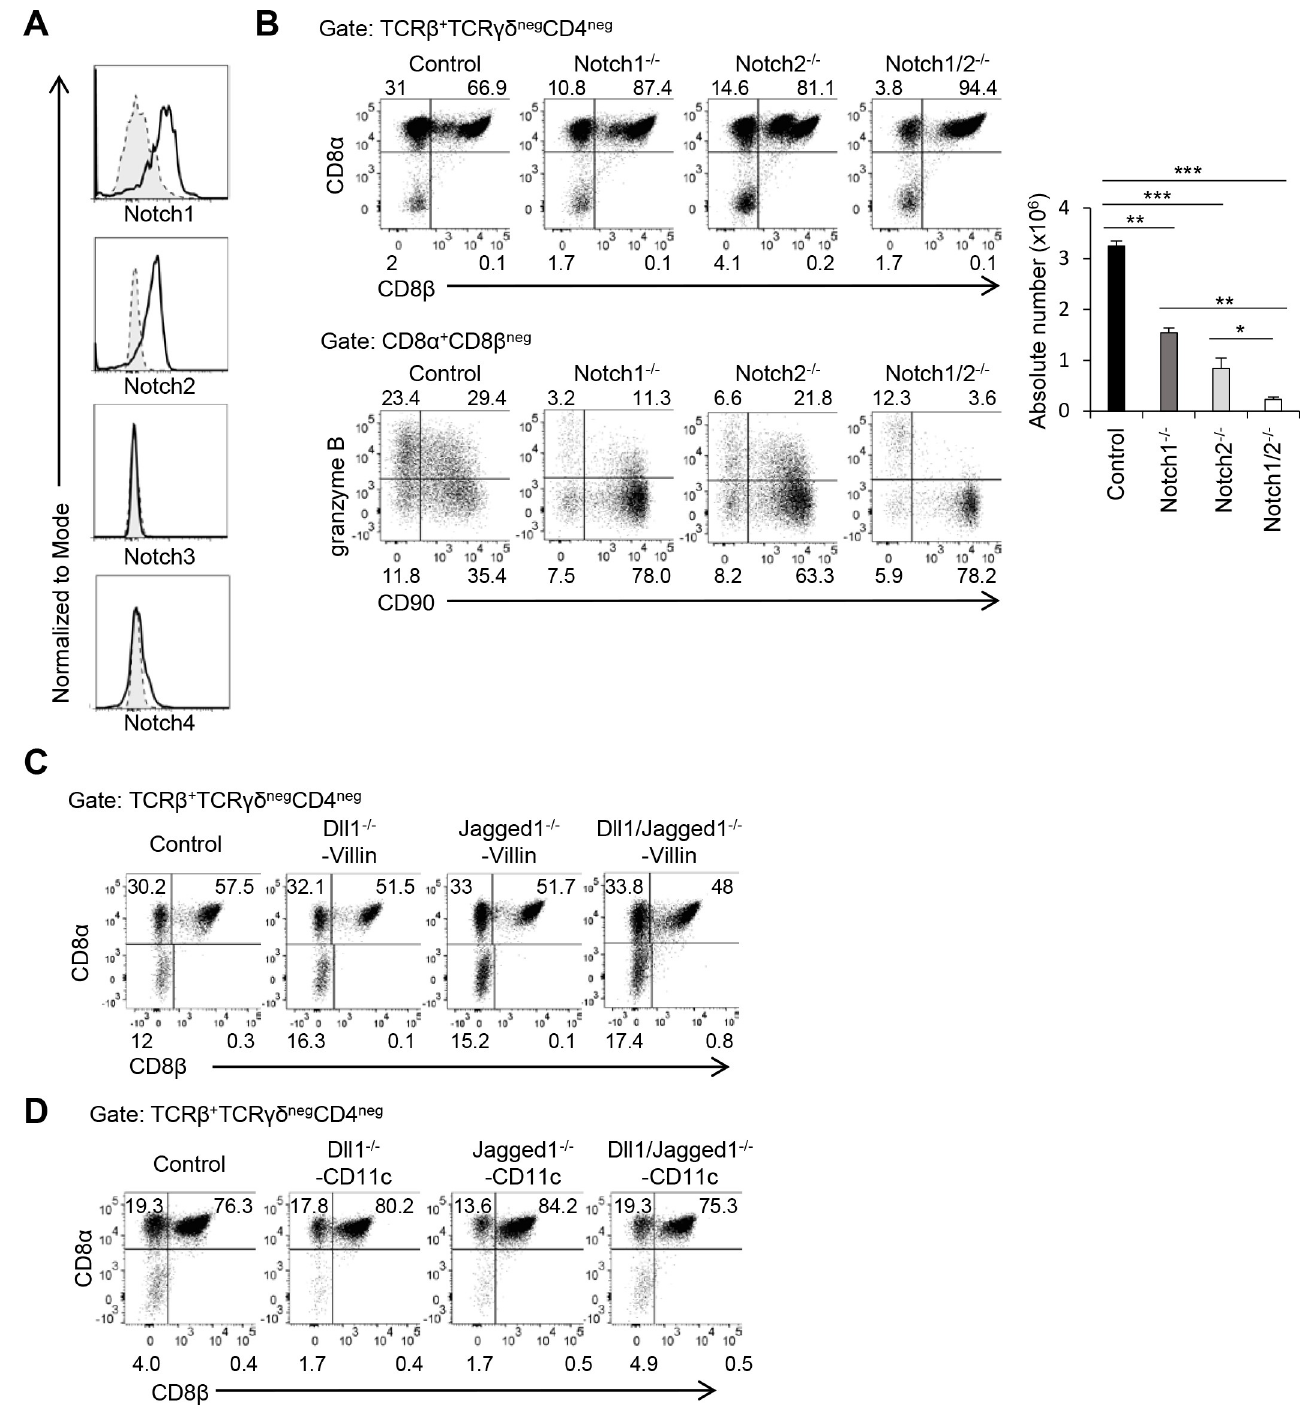
Fig 3. Notch1 and Notch2 are major receptors that regulate TCR αβ + CD8 αα + IELs. (A) Expression of Notch1, Notch2, Notch3, or Notch 4 on TCR αβ + CD8 αα + IELs evaluated by flow cytometry. Shadow: isotype control; solid line: Notch antibody. (B) The frequency of TCR αβ + CD8 αα + IELs or CD90/granzyme B expression on TCR αβ + CD8 αα + IELs in Notch1 − / − , Notch2 − / − , and Notch1/2 − / − mice. The data are representative of three independent experiments and are shown as mean ± S. D., and � , �� , or ��� indicates p < 0.05, p < 0.01, or p < 0.001, respectively. (C) The frequency of TCR αβ + CD8 αα + IELs in Dll1 − / − -Villin, Jagged1 − / − -Villin, and Dll1/ Jagged1 − / − -Villin mice. (D) The frequency of TCR αβ + CD8 αα + IELs in Dll1 − / − -CD11c, Jagged1 − / − -CD11c, and Dll1/Jagged1 − / − -CD11c mice. The data in this figure are representative of three independent experiments. Data associated with this figure can be found in the supplemental data file (S1Data).Dll1, Delta-like 1; IEL, intraepithelial lymphocyte; N.S.; not significant; Rbpj, recombination signal binding protein for immunoglobulin kappa J region.